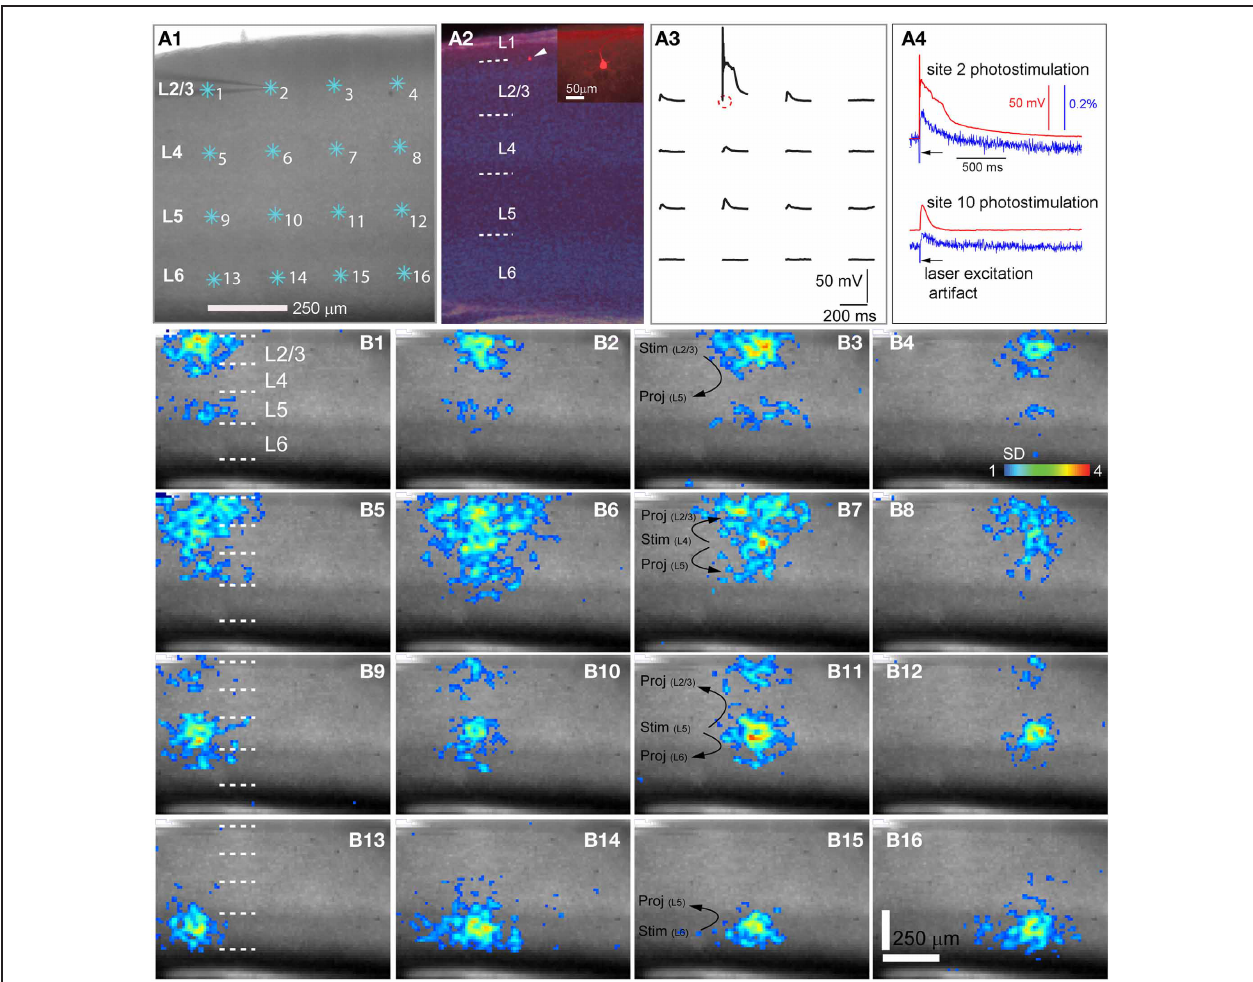
FIGURE 1 | High precision and fast mapping of local V1 laminar circuit organization through laser scanning photostimulation and voltage-sensitive dye (VSD) imaging. (A1) Shows the slice image with cyan asterisks indicating a 4 × 4 stimulus pattern covering V1 from cortical layer 2/3 to layer 6. The glass microelectrode was recording from a single pyramidal neuron in the upper layer 2/3 during photostimulation and imaging for monitoring the spatial precision of laser photostimulation and correlating single-cell activity with the VSD signal of the population response. (A2) Shows the DAPI-stained image of the same V1 slice recorded in A1, with an overlay image of the cell stained against biocytin (pointed by the white arrowhead). The insert in A2 shows the morphology of the recorded pyramidal cell under a higher magnification. The short dashed white lines in A2 , B1,B5,B9 and B13 denote the laminar boundaries of cortical layers 1, 2/3, 4, 5, and 6. (A3) Indicates spatially restricted neuronal activation via photostimulation by plotting the changes in the membrane potential of the recorded neuron in response to photostimulation of the 4 × 4 sites shown in A1 . The small circle indicates the cell body location. (A4) Shows data traces